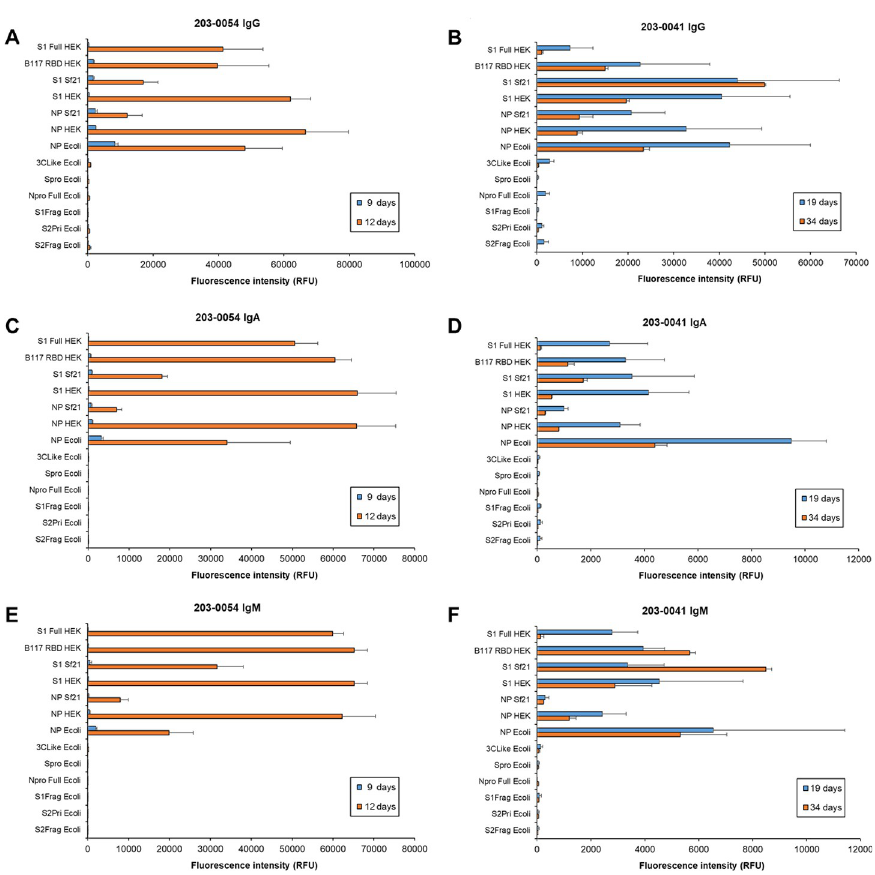
Fig 7. Dynamic binding of patient serum antibody isotypes over short to medium term for moderate and mild COVID-19 disease. Bar charts represent binding intensity data for serum (A,B) IgG, (C,D) IgA, and (E,F) IgM binding to SARS-CoV-2 antigens for patient 203–0054 ( A,C,D ; moderate, M, 50 years) and 203–0041 ( B,D,F ; mild, M, 80 years) at 9 and 12 days, and 19 and 34 days post-first symptom onset, respectively. Bars represent the average binding intensity from three replicate experiments with error bars of +/- 1